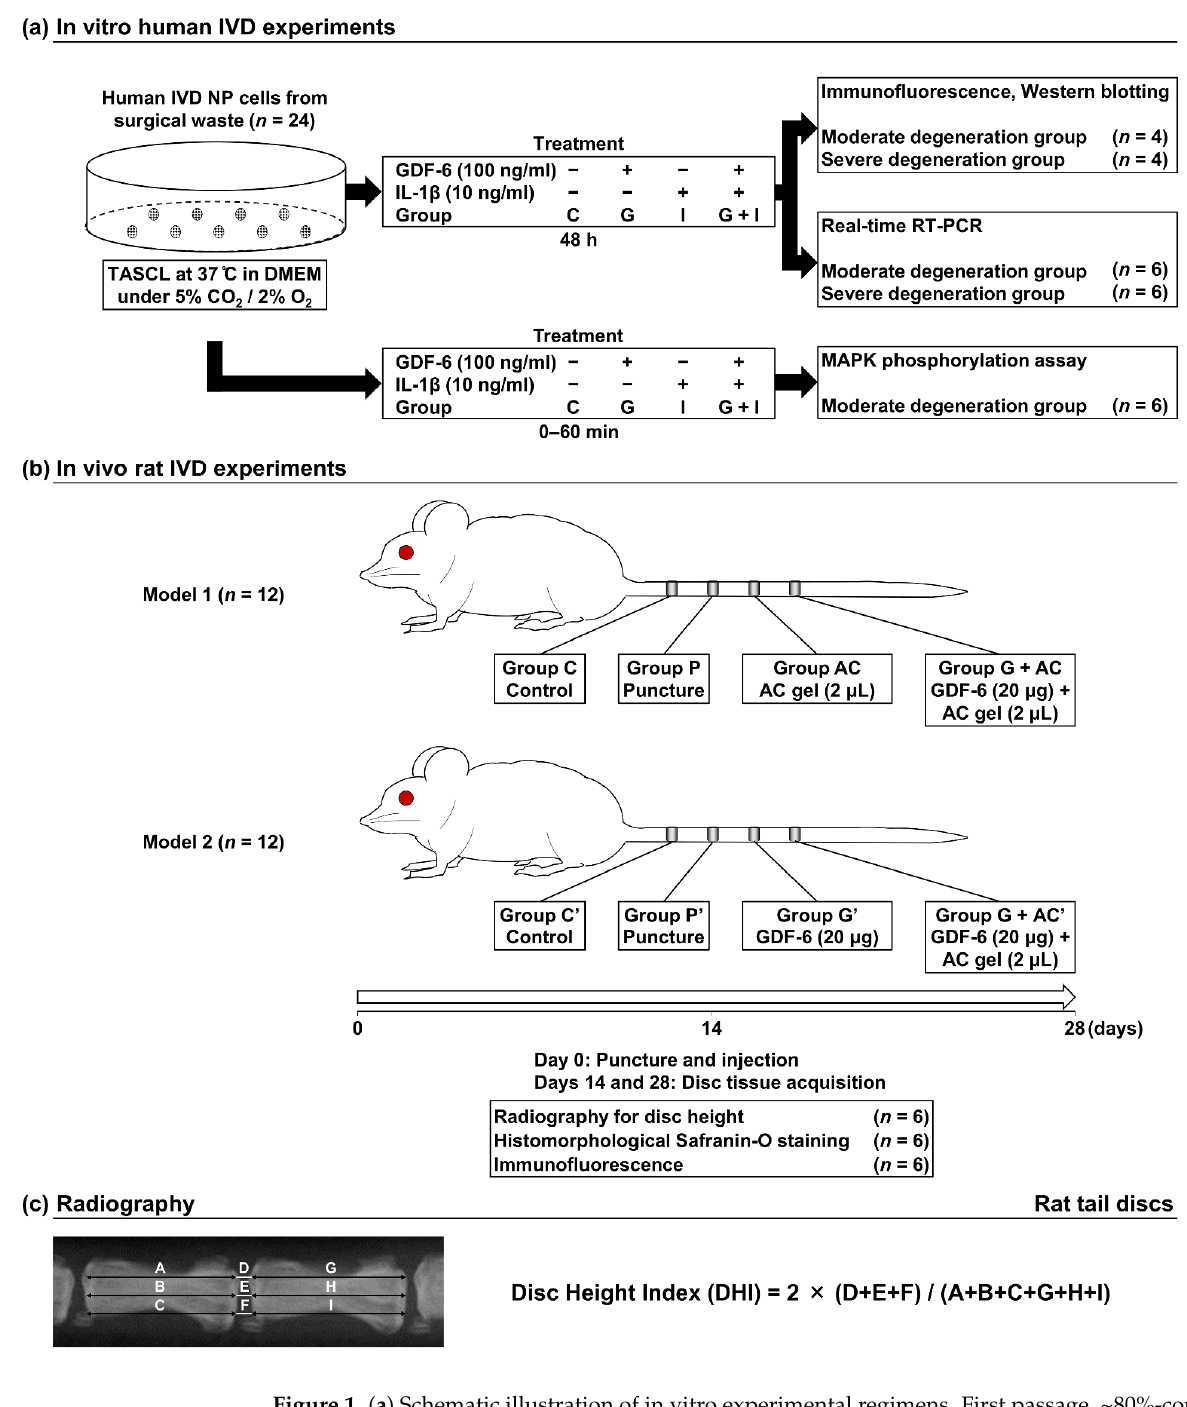
Figure 1. ( a ) Schematic illustration of in vitro experimental regimens. First passage, ~80%-confluent human intervertebral disc (IVD) nucleus pulposus (NP) cells from surgical waste in patients with degenerative lumbar spine disease (total n = 24) were cultured as a monolayer in Dulbecco’s modi- fied Eagle’s medium (DMEM) with 1% penicillin-streptomycin (PS) and 10% fetal bovine serum (FBS) at 37 °C under 5% CO 2 and 2% O 2 , followed by seeding into a three-dimensional culturing system (Tapered Stencil for Cluster Culture [TASCL]) to form cell clusters. Cell clusters were treated with growth differentiation factor (GDF)-6 (100 ng/mL, group G), interleukin (IL)-1β (10 ng/mL,